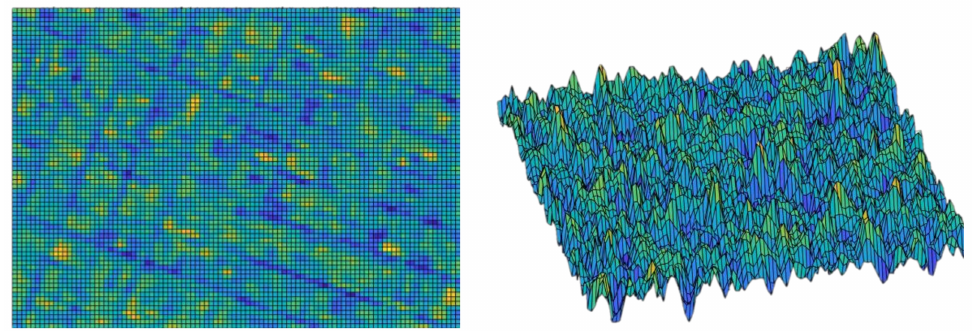
Figure 14. Area division using noise in the image.